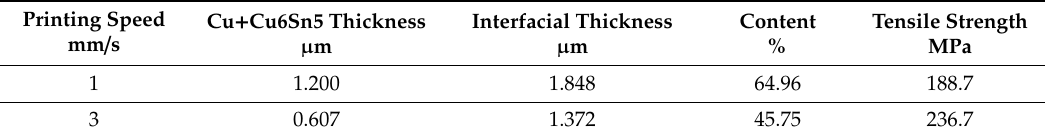
Table 7. Thickness of Cu + Cu6Sn5 vs. tensile